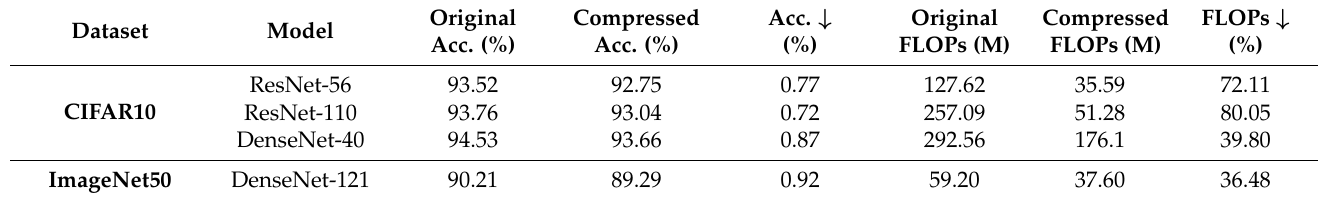
Table 4. All compression results by our proposed method.